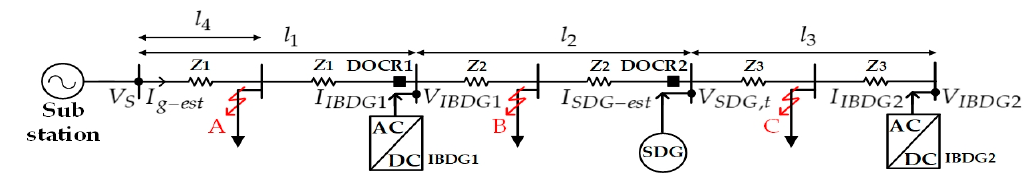
Figure 6. Radial distribution system.